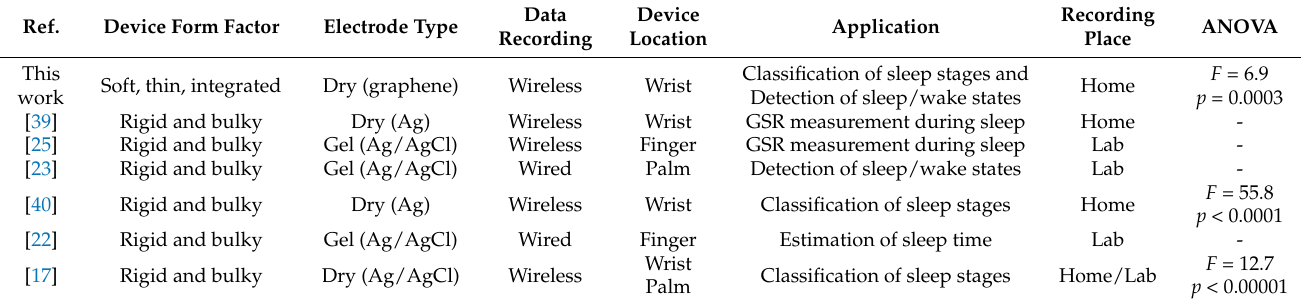
Figure 4. Determination of four sleep stages based on GSR data. ( A ) Raw EEG spectrogram measured during sleep (top), hypnogram derived from the EEG data showing four sleep stages, including REM, N1, N2, and N3 (middle), and measured GSR data during sleep (bottom). The RMS values from GSR data show a continuous low tendency below the fixed threshold, verifying the entire epochs are in sleep status. ( B ) Comparison of classified sleep stages from EEG data with GSR data in three epochs. ( C ) Summarized correlation between sleep stages and GSR counts from three epochs in ( B ). Error bars: standard deviation from three trials. ( D ) Summary of statistical analysis using ANOVA, showing the data significance in ( C ). High significance is identified in epoch 2 ( F = 6.878, p = 0.0003, η 2 = 0.16). Table 1. Comparison of wearable GSR-recording devices for a sleep study.